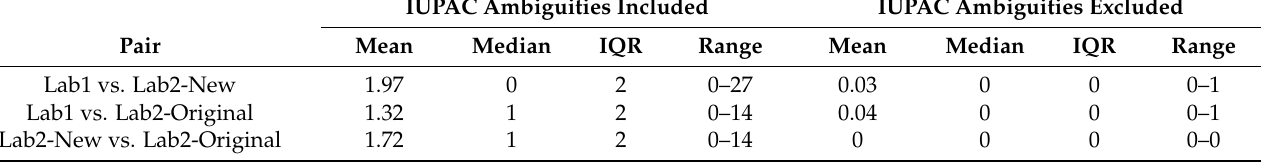
Table 1. Summary statistics comparing the number of differences in pairwise sequence compar- isons between matched samples from the same patient that were sequenced at different lab sites with/without using the same bioinformatics pipeline. Abbreviations: IQR = interquartile range; Lab1: Lab1 sequence assembled with Lab1 bioinformatics pipeline; Lab2-New: Lab2 sequence assembled with Lab1 bioinformatics pipeline; Lab2-Original: Lab2 sequence assembled with Lab2 bioinformatics